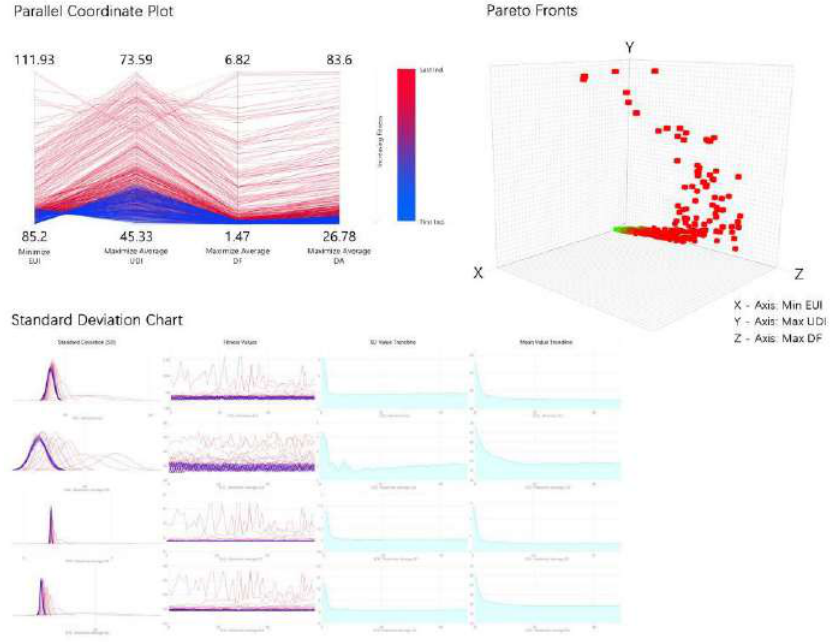
Figure 9. Parallel coordinate plot, Pareto Fronts output, standard deviation, and trendline of each index in medium-sized, west-oriented classrooms.